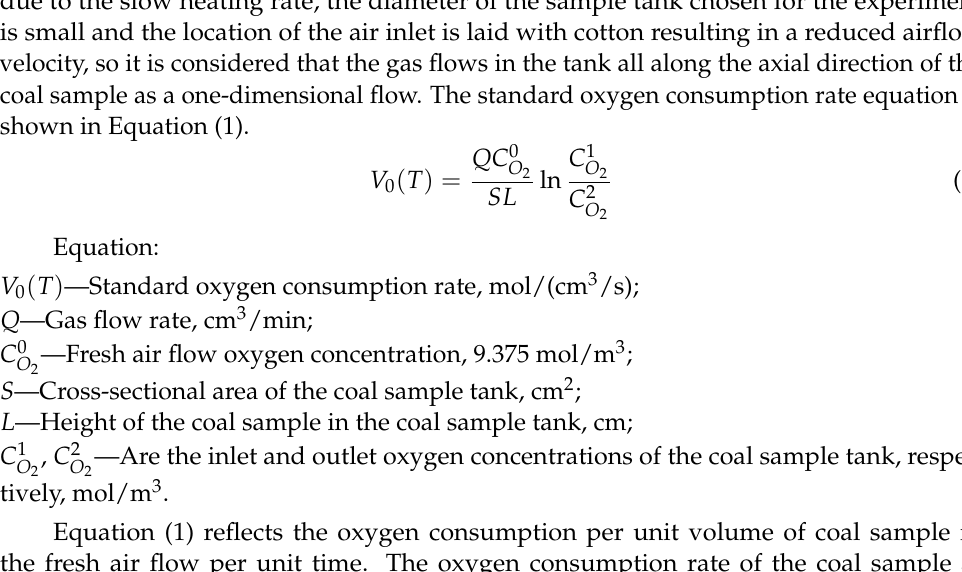
Figure 2. Trend of O 2 concentration with temperature during the warming process of coal